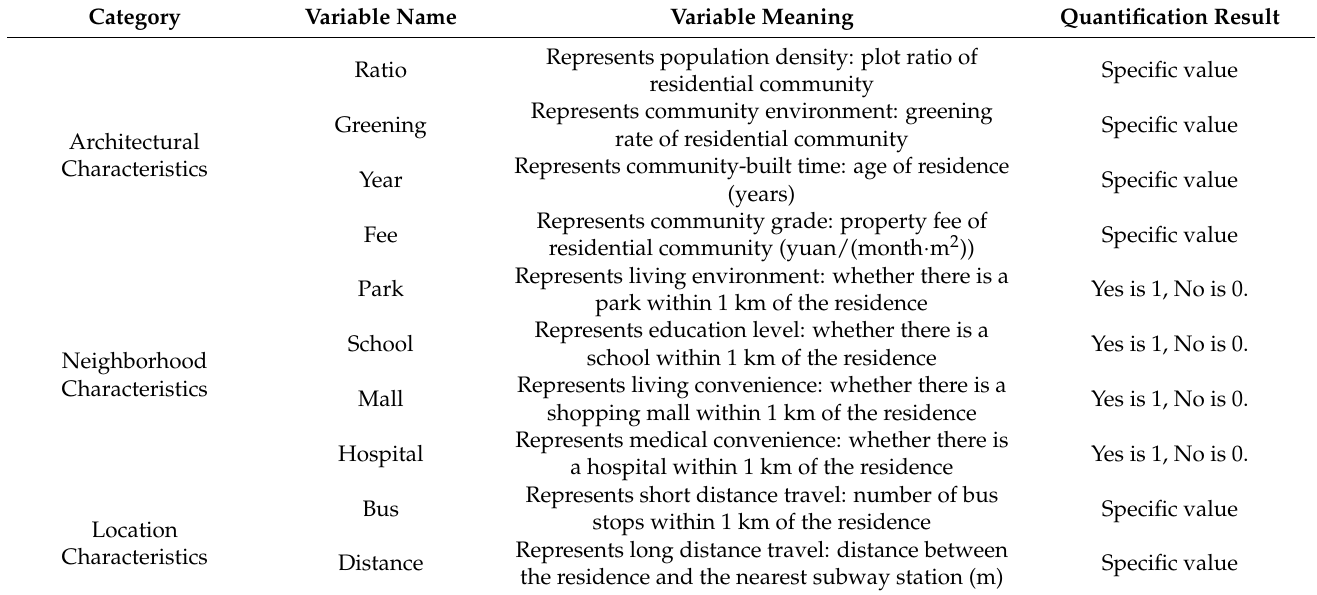
Table 1. Variable properties of the hedonic price